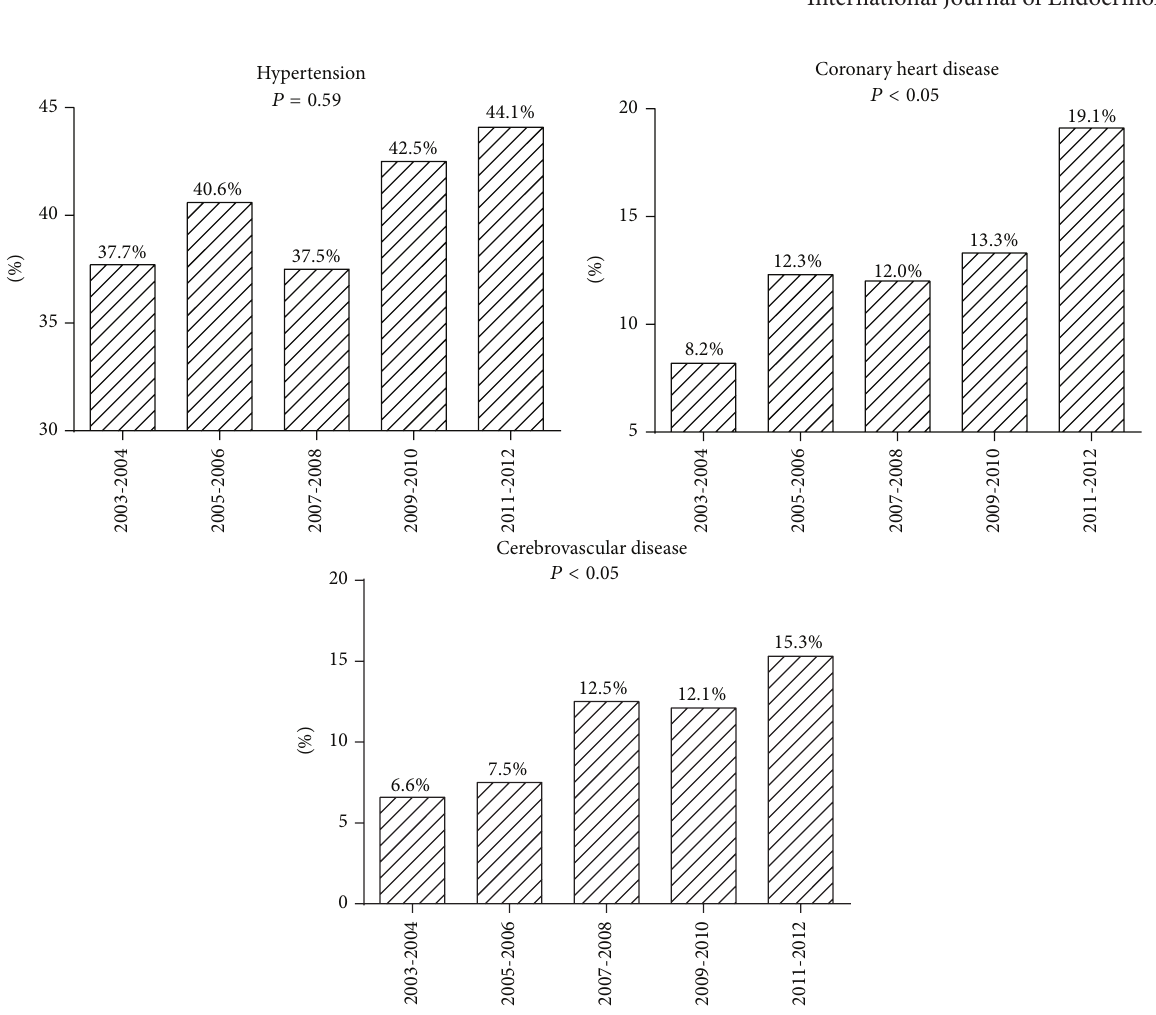
the effects of lifestyle factors on serum levels of lipids. Third, the patients taking lipid-lowering medication were excluded; the percentages of people with dyslipidemia did not include these